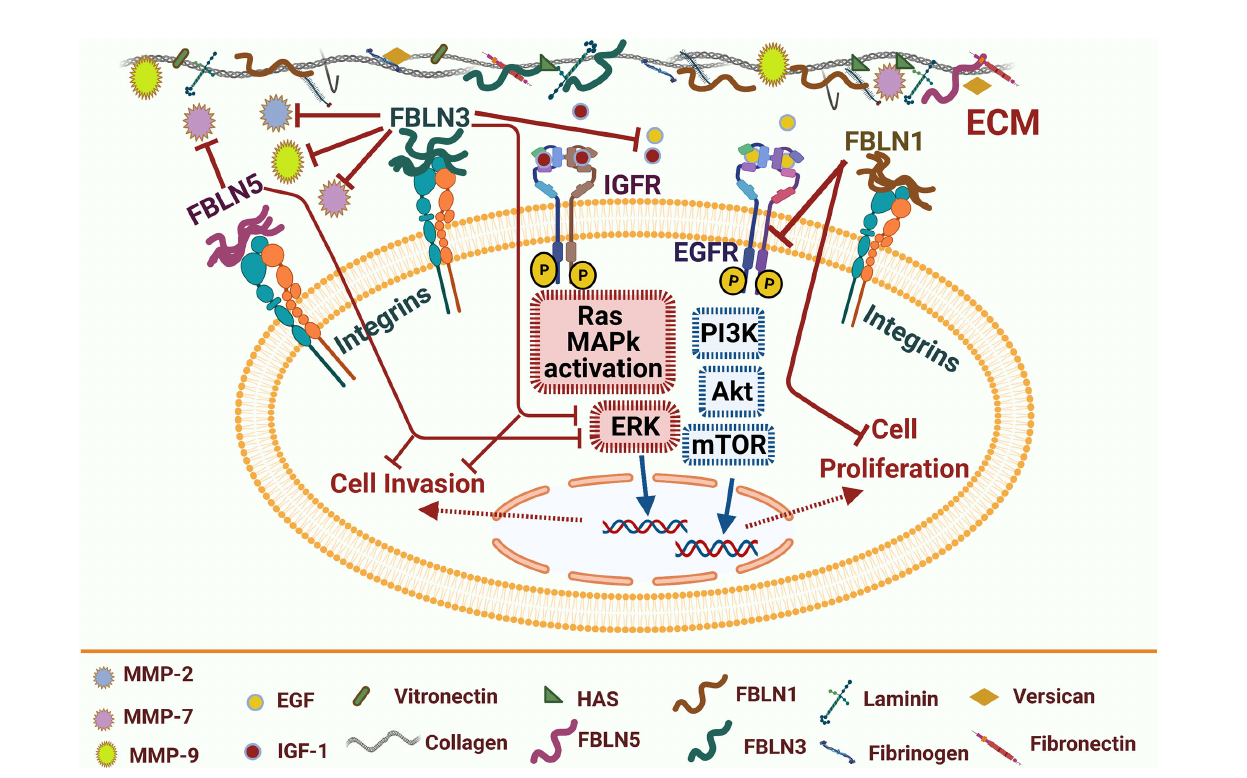
FIGURE 2 | Fibulins-mediated EGFR signaling pathways and matrix metalloproteinases in lung cancer. Fibulin (FBLN) family includes many types such as FBLN1,3&5 serve as tumor-suppressor proteoglycans. FBLN1 can inhibit EGFR activation and thus suppress cell proliferation. FBLN3 can compete with EGF and IGF-1 binding to their receptors; it also can inhibit transcription of oncogenic matrix metalloproteinases (MMP2& MMP9). FBLN3/5 can inhibit MMP7 and Erk pathway activation and thus inhibit cell invasion. Blue arrows for stimulation; dashed red arrows for cellular effect, and red “ T ” sign for